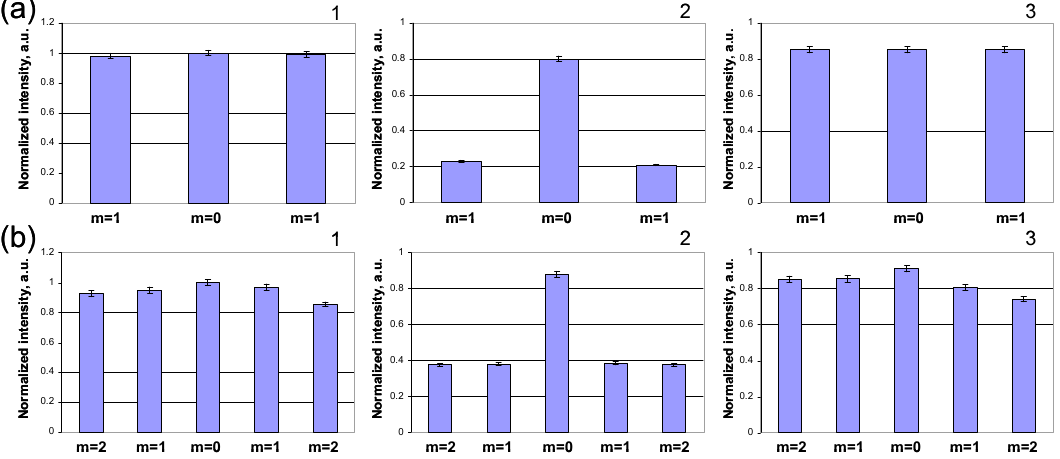
Figure 7. Normalized di ff raction intensity distribution of the ( a ) 2A and ( b ) 4B microstructured PETMP-TTT films: (1) imprinted, (2) after deformation, (3) after